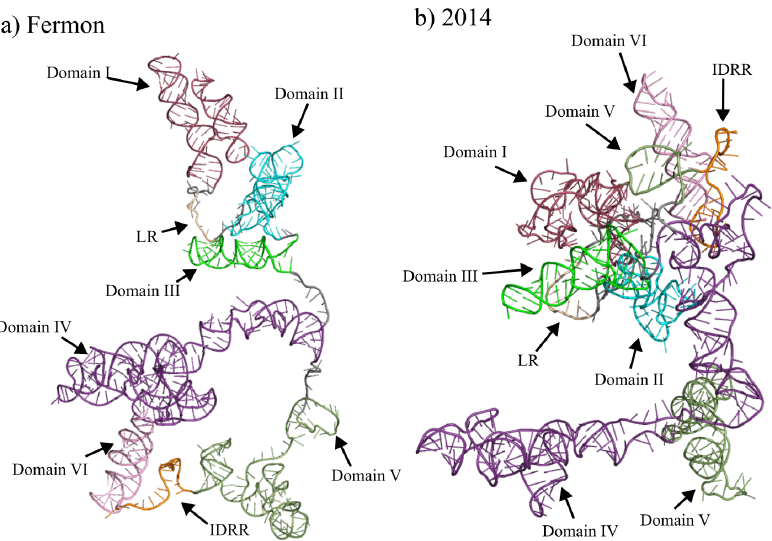
Figure 3. Tertiary structure models of the 5 ′ UTRs of EV-D68 Fermon and 2014 strains. Panels ( a ) and ( b ) represent the tertiary structure predictions generated using 3DRNAv2.0 for the 5 ′ UTRs of the Fermon and 2014 strains, respectively. Structural predictions were visualized and pseudocolored using PyMOL. Pseudocoloring follows the same coloring pattern as shown in panel (c) of Figure 2, and structures of interest are labeled as shown in panels of Figure 2.